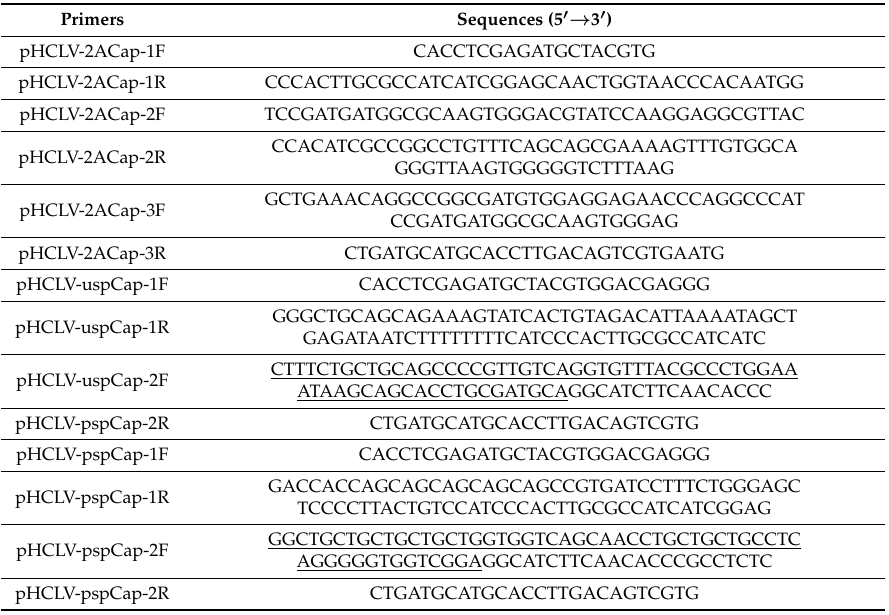
Figure 1. The viral genome organizations of the recombinant viruses derived from the CSFV C-strain. The viral genome organizations of the parental virus HCLV/rHCLV ( A ) and rHCLV-2ACap ( B ). The 7-aa linker and the porcine teschovirus 1 2A (P2A) are shown. The cleavage sites of N pro and P2A are indicated as arrows; ( C ) rHCLV-uspCap harboring the Cap gene without the nuclear localization sequence (dCap) is illustrated, and the signal peptide of ubiquitin-specific peptidase gene is inserted in the N-terminus of dCap; ( D ) rHCLV-pspCap harboring dCap is illustrated, and the signal peptide of the prolactin gene is inserted in the N-terminus of dCap. Table 1. Primers used for construction of the recombinant infectious clones. Primers